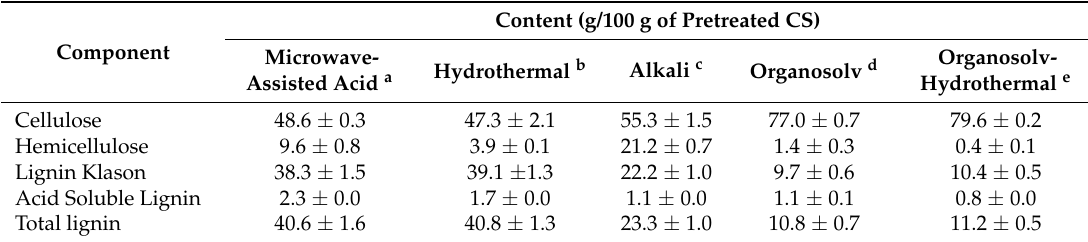
Table 1. Compositional analysis of pretreated cotton stalks